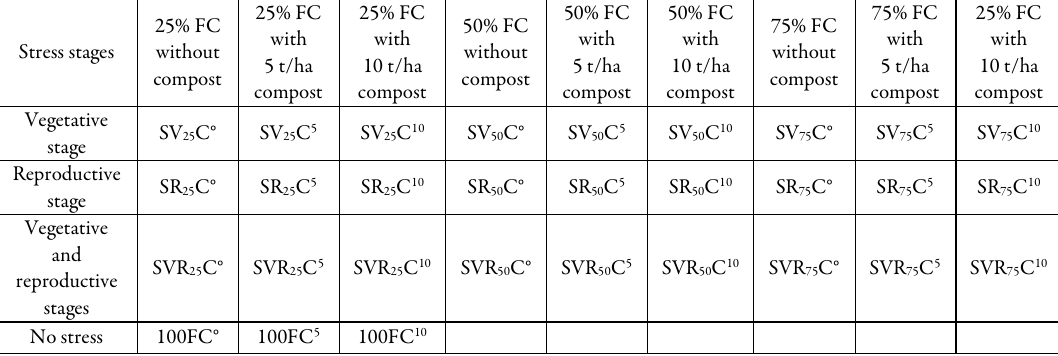
Table 1. The acronyms used for the experimental treatments Stress